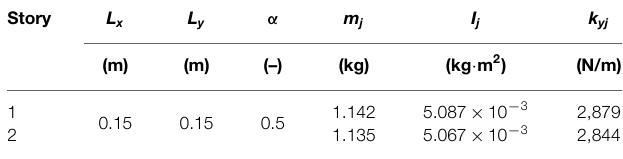
TABLE 4 | Parameters of experimental